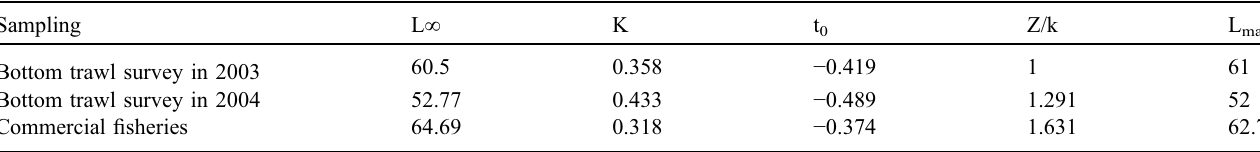
Table 4. Growth parameters of P. blennoides estimated by FISAT II software. L ∞ : asymptotic length (cm) obtained by Powell Wetheral ’ s method. K: growth rate (year (cid:3) 1 ) obtained applying the equation of Pauly and Munro (1984). t 0 : size when age is zero, L max: Maximum observed size in cm.